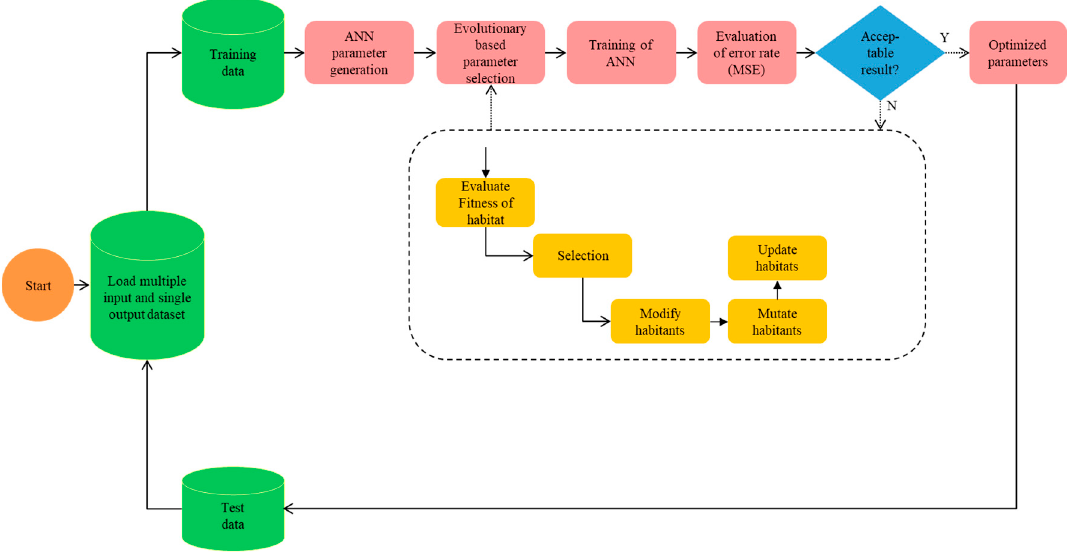
Figure 5. Process flow chart of the proposed BBO-ANN.